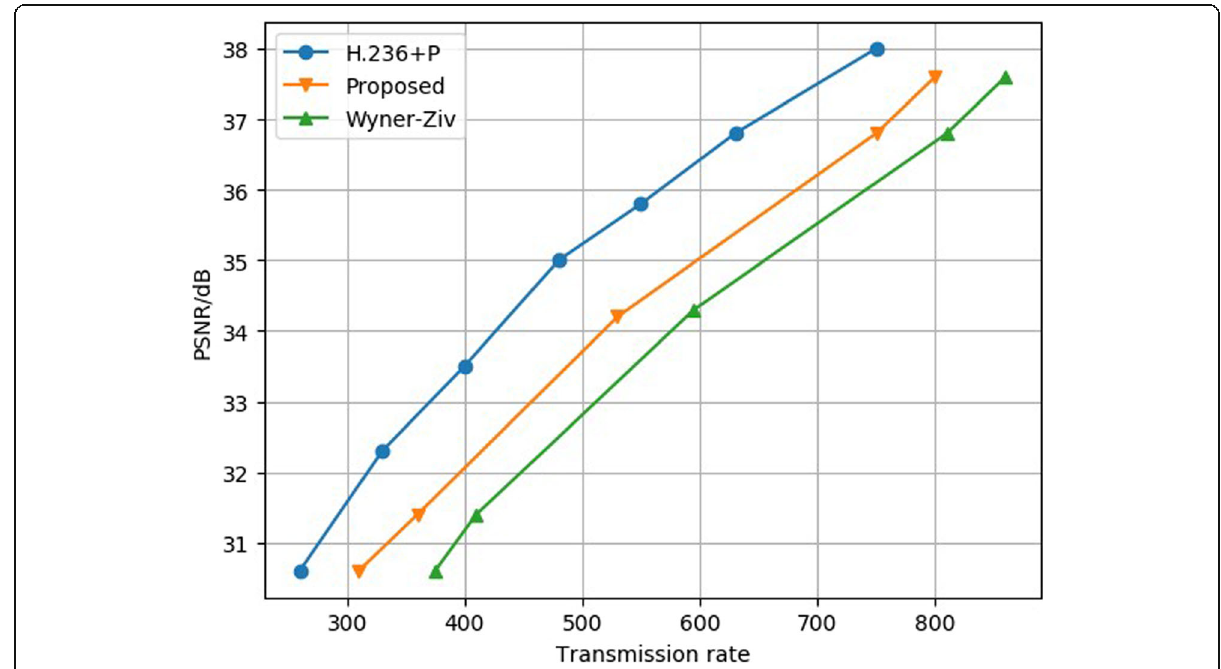
Fig. 2 Foreman ’ s transmission rate and peak signal to noise ratio comparison